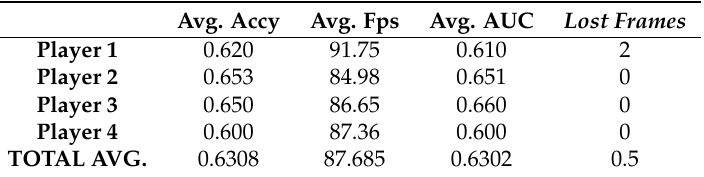
Table 1. Average hybrid algorithm